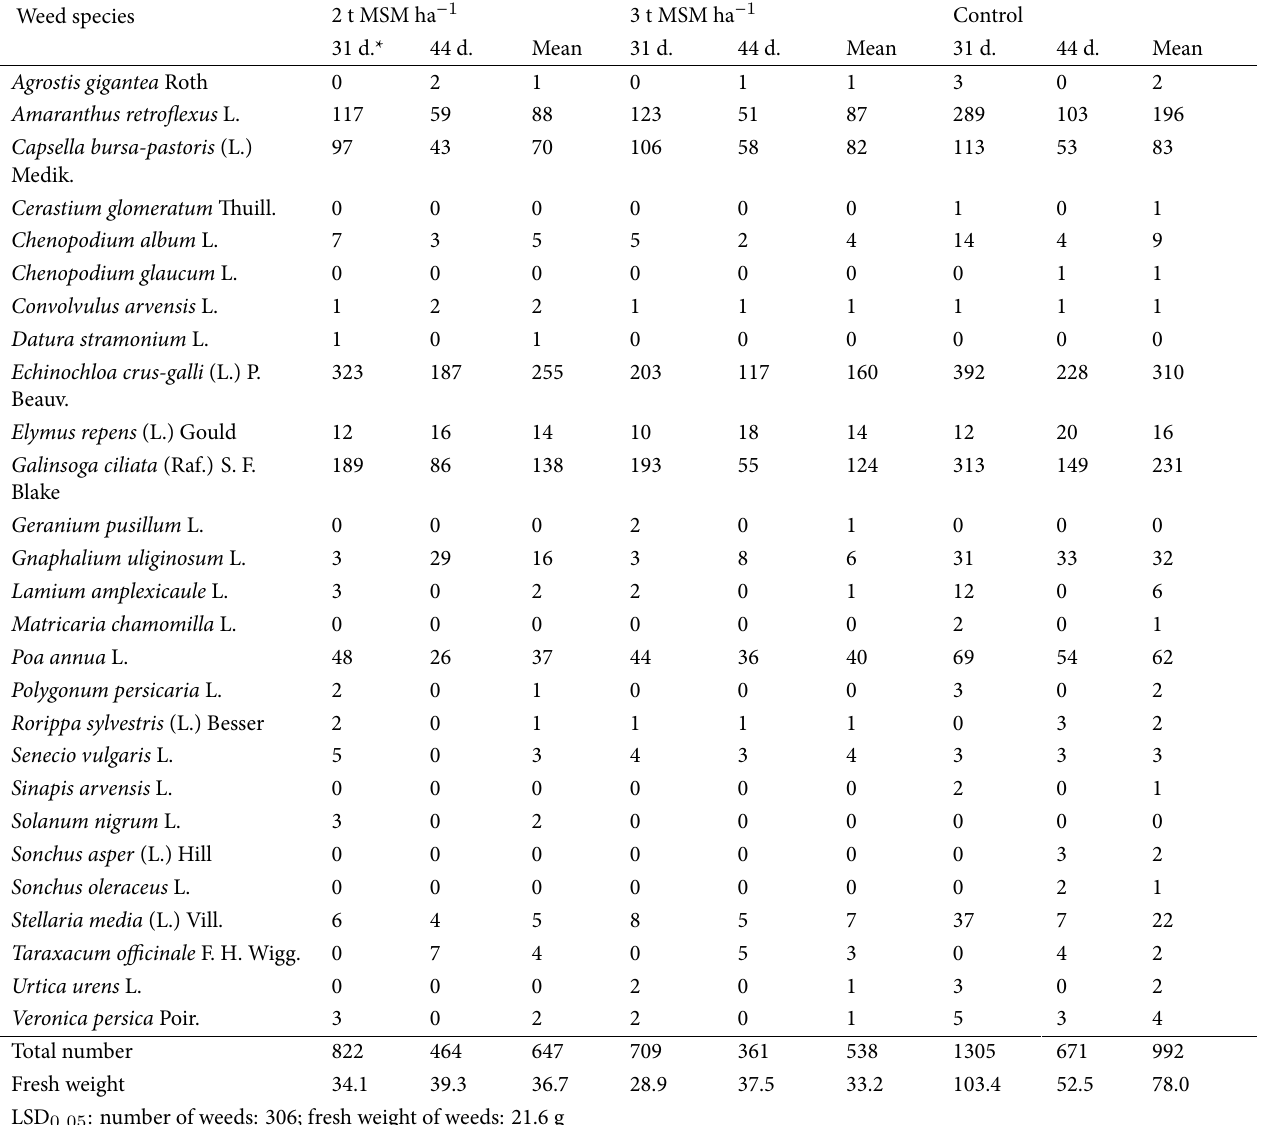
Table 3 Effect of mustard seed meal on number (pcs m borage